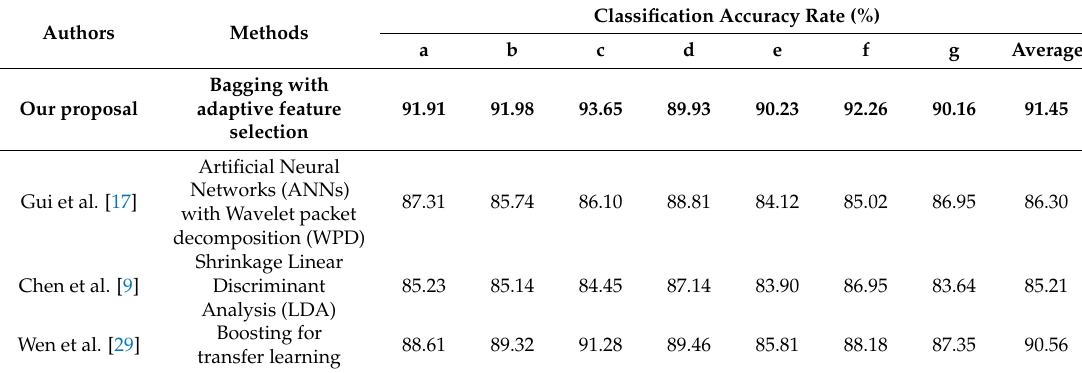
Table 6. Performance comparisons with the existing